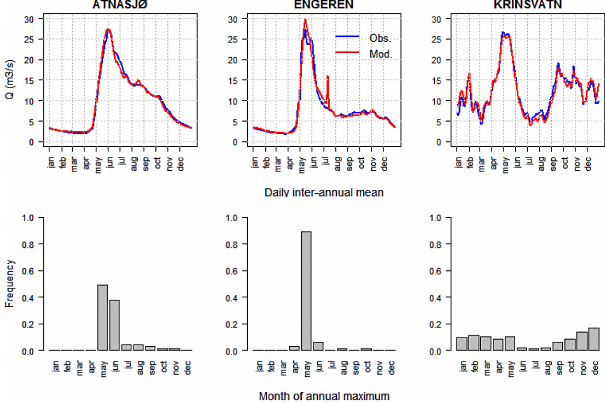
Figure 8. Daily inter-annual mean for both observed and modelled values and relative frequency of annual maxima by month.